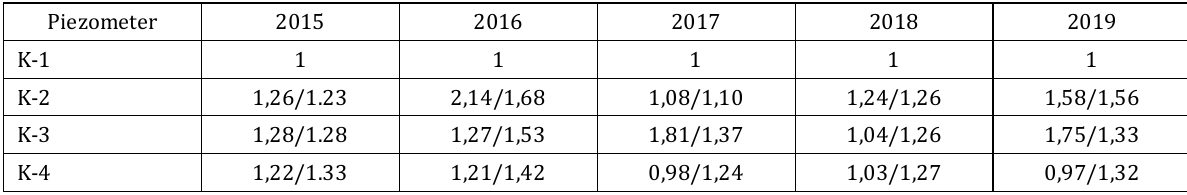
Table 3. Minimum, maximum and average results for individual parameters Piezometer